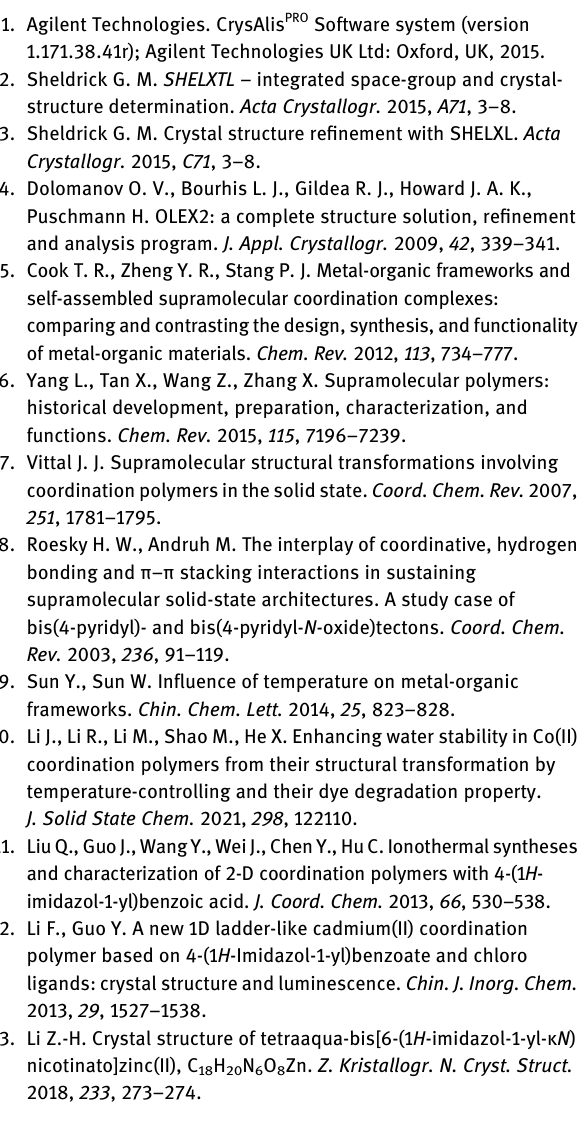
Table  : Fractional atomic coordinates and isotropic or equivalent isotropic displacement parameters (Å 